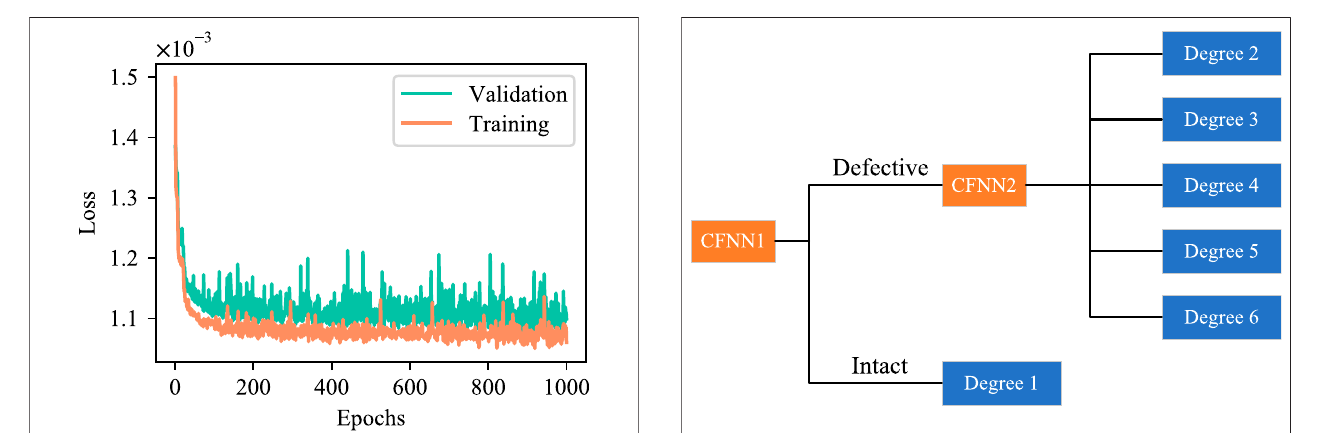
FIGURE4| DiagramoftheCFNNwiththedecisiontreedesignedforfuel failure detection.